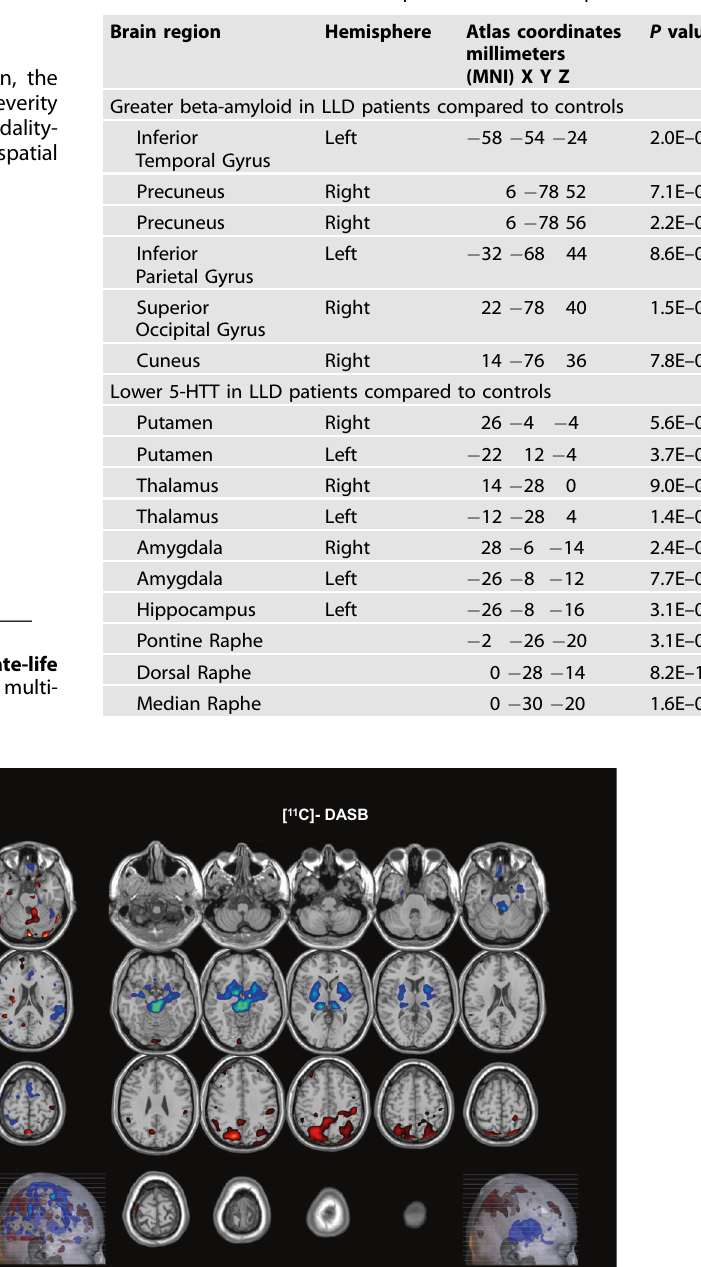
Table 3. The peak voxel locations of the co-varying spatial patterns of Greater Beta-Amyloid and the Serotonin Transporter (5-HTT) determined by multi-modal Partial Least Squares (mmPLS) for the Normal Controls and Late-Life Depressed Patient Groups.